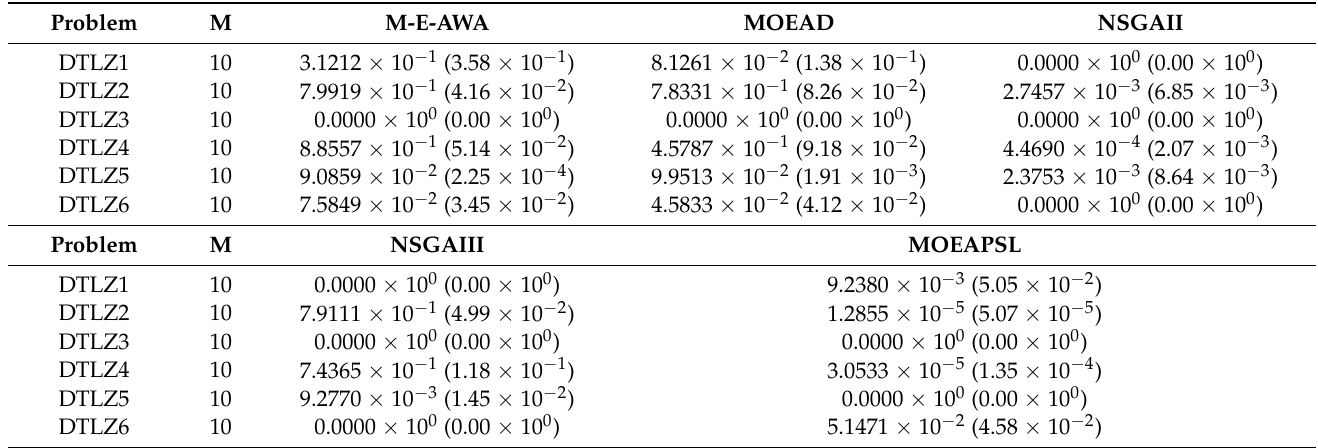
Table 7. Comparison of HV values between M-E-AWA and contrast algorithms on DTLZ1– DTLZ6(The target number is 10).